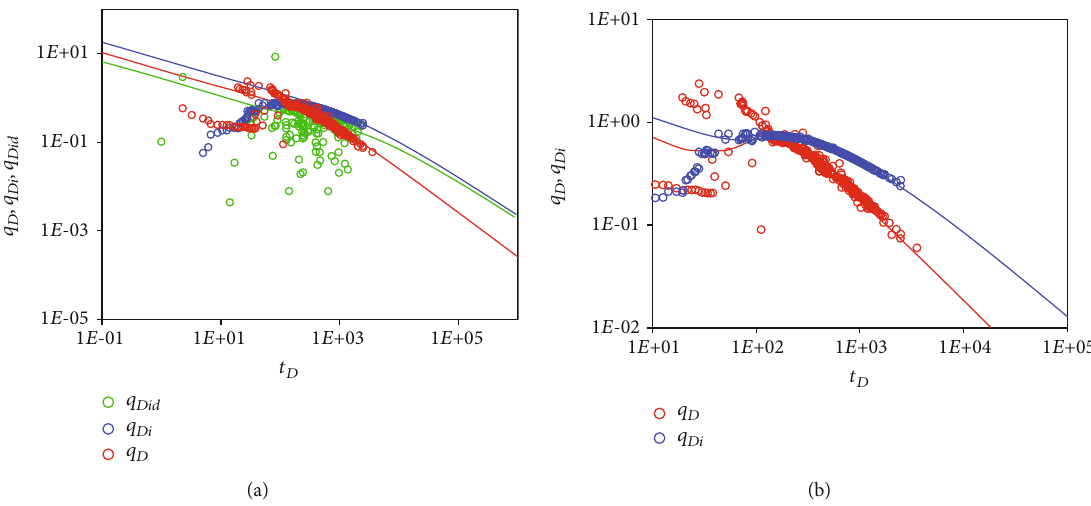
Figure 15: Type curve fi tting of YY-3 production data considering (a) and ignoring (b) the uneven support of fractures.